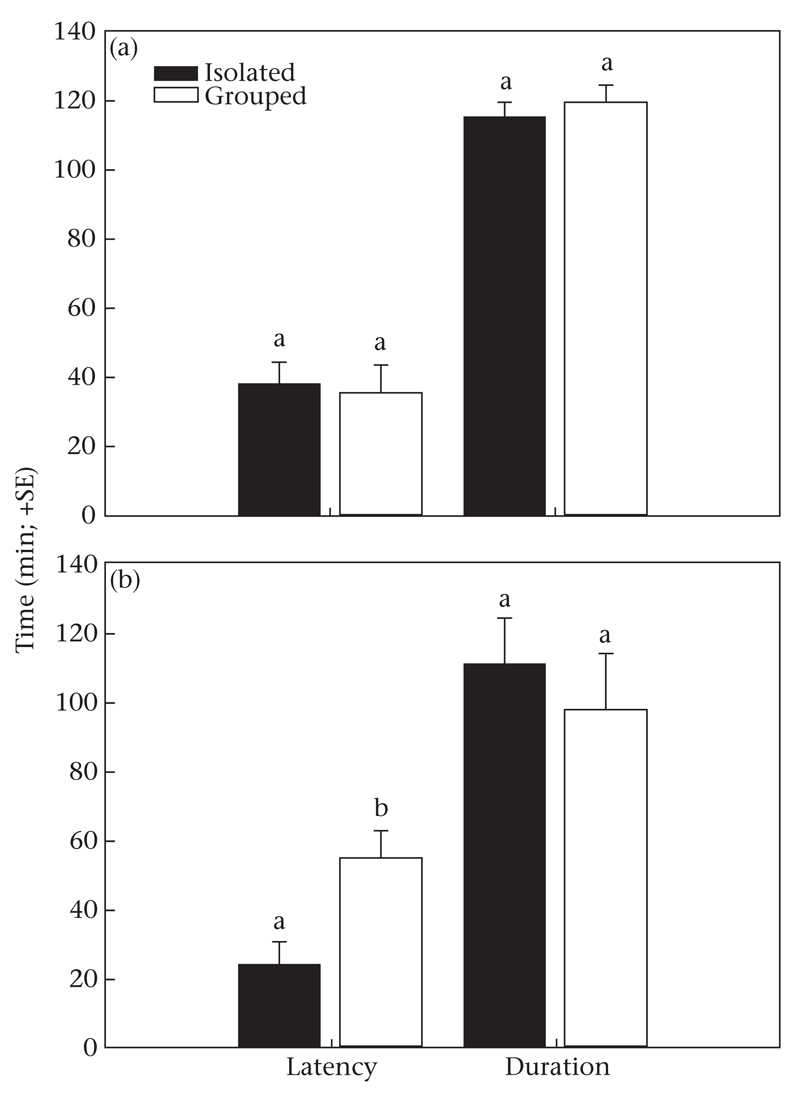
Latency and duration of the first mating in triplets consisting of (a) one male and two females or (b) one female and two males. In both (a) and (b), one individual of the competing sex was socially deprived (reared in isolation until adult) and the other was socially enriched (reared in a conspecific group) (experiment 2). Different letters the males above bars indicate significant differences between isolated and grouped individuals (GLM: P < 0.05).